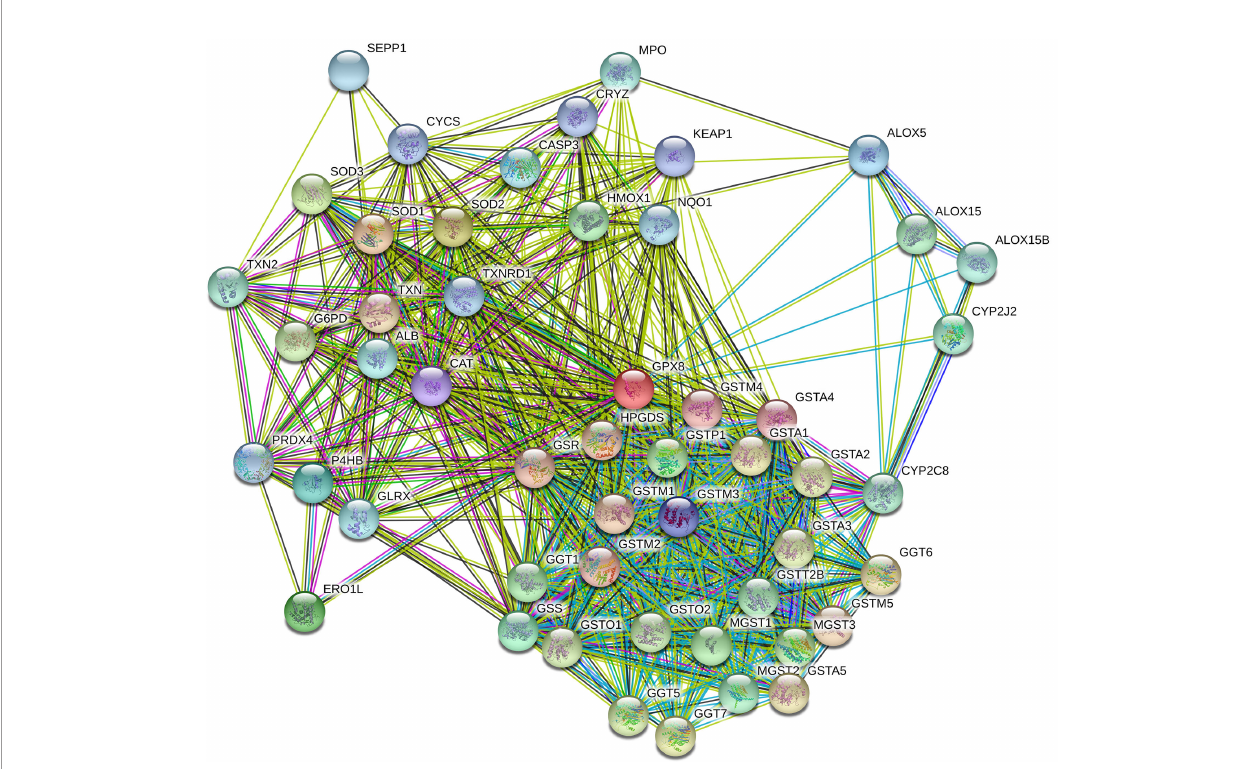
FIGURE 9 | PPI network complex of GPX8. The number of nodes was 11, while the number of edges was 32. The average node degree was 5.82. The average local clustering coef fi cient was 0.858. The PPI enrichment P-value was 5.92e – 07. The most signi fi cant nodes were SOD1, SOD2, SOD3, ERO1L, GSS, P4HB, ALOX5, GSTM3, CAT, and